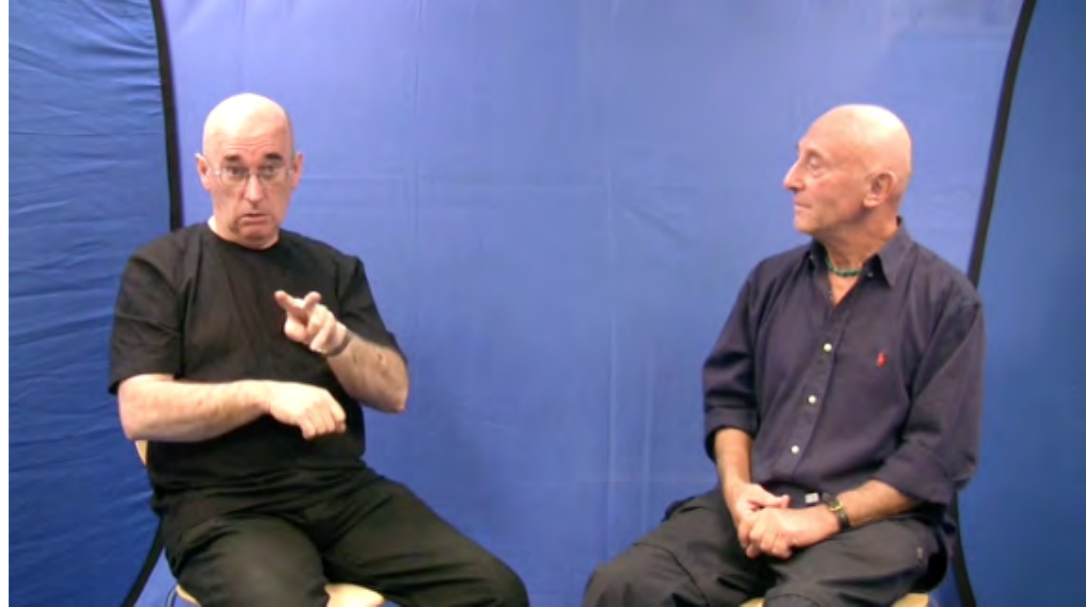
Figure 10 . Modified form of BSL look02 used with constructed action (‘CA with eyegaze and other articulators’), with signer